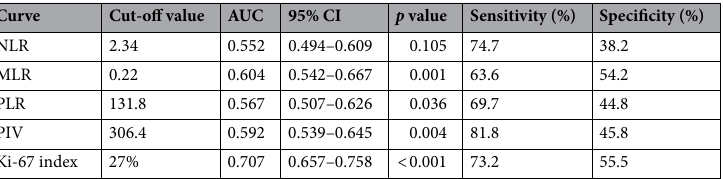
factor of pCR among blood-derived inflammation markers in multivariate analysis 29 . In another study con- ducted by Peng et al., multivariate analysis of 808 breast cancer patients showed that the lymphocyte-monocyte ratio was the only independent predictive factor for the efficacy of NAC among these inflammatory markers 32 . In addition, Hu et al. stated that PLR had superior efficacy to NLR in predicting NAC response 33 . When these studies are evaluated together with scholars presenting negative results 34 , it has emerged offering a combination